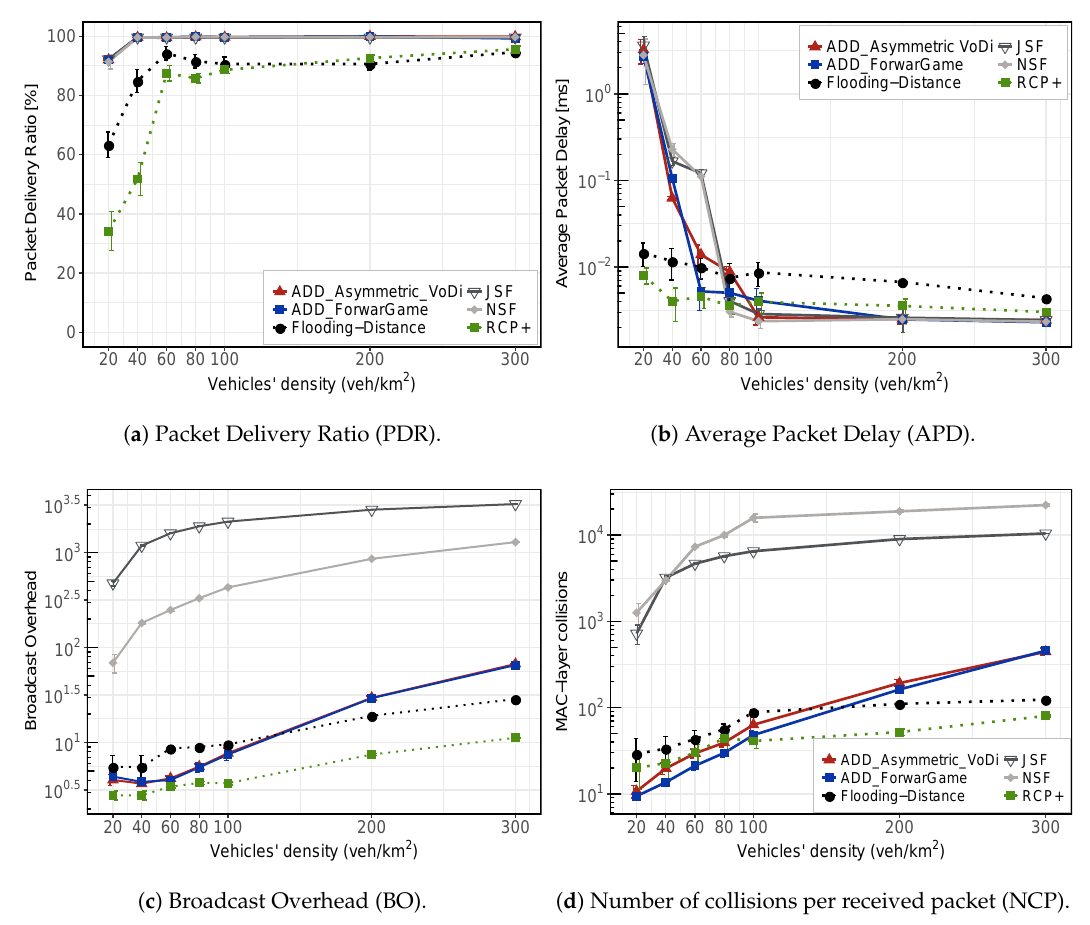
Figure 4. Results with 95% confidence intervals for 10 repetitions per point with independent seeds. Text dissemination case. Different vehicles’ densities in a 2.5 km × 2.5 km urban region in Berlin,